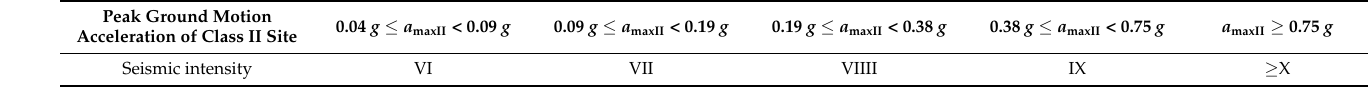
Table 7. The comparison table between the peak acceleration and the seismic intensity.